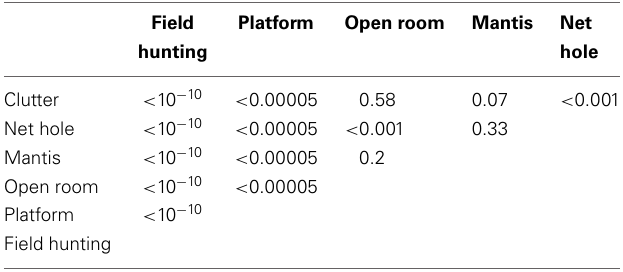
Table 3 | p -values for pairwise, two-tailed T -tests performed on the sonar sound group PI data reported in Figure